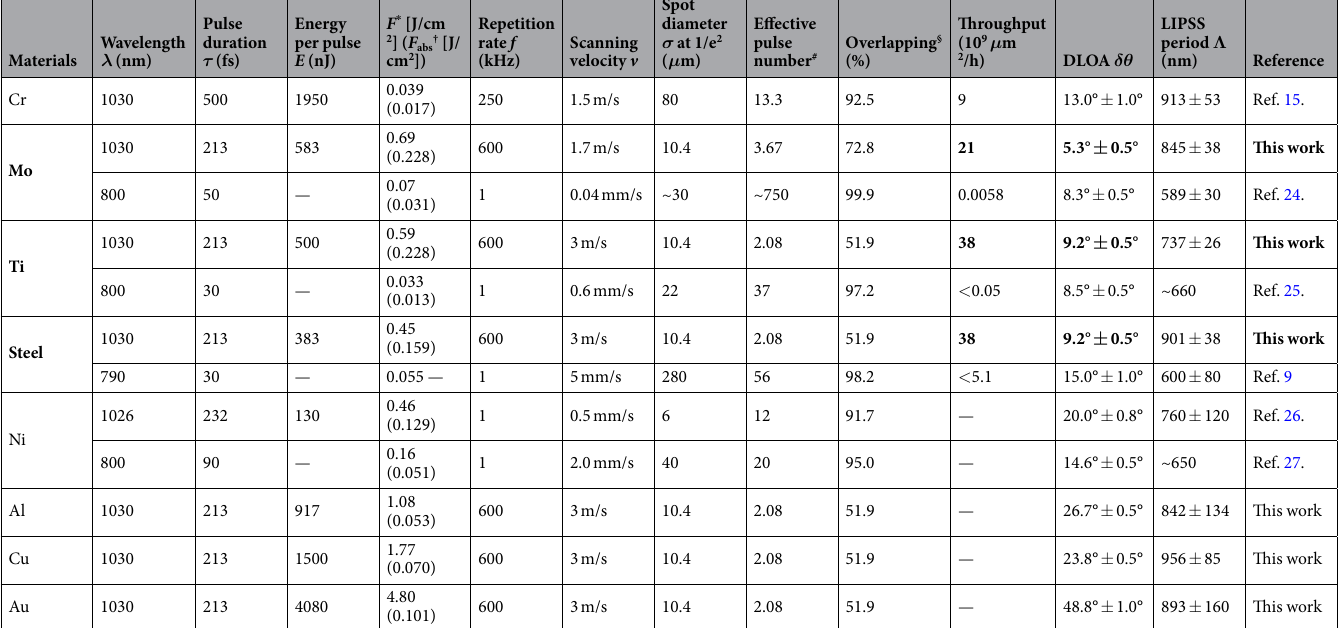
Table 1. Set of parameters used in the present work and in several references where regular LIPSS